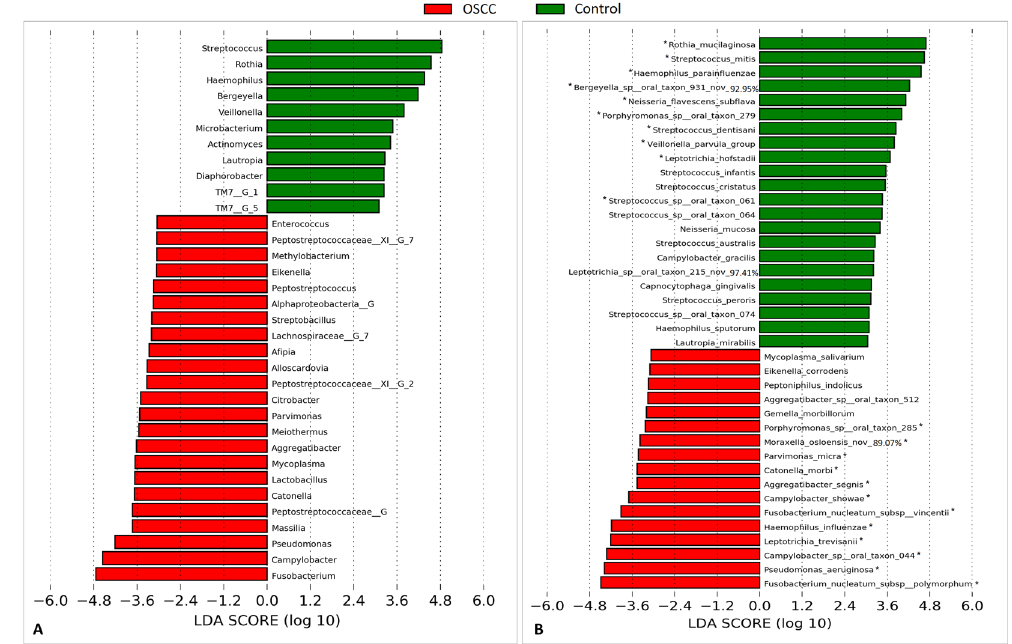
Figure 4. Differentially abundant taxa. Linear Discriminant Analysis Effect Size (LEfSe) analysis showing genera ( A ) and species ( B ) that were significantly differentially abundant between the cases and controls (LDA score ≥ 3). * The difference is also significant by G-test (False discovery rate = 0).